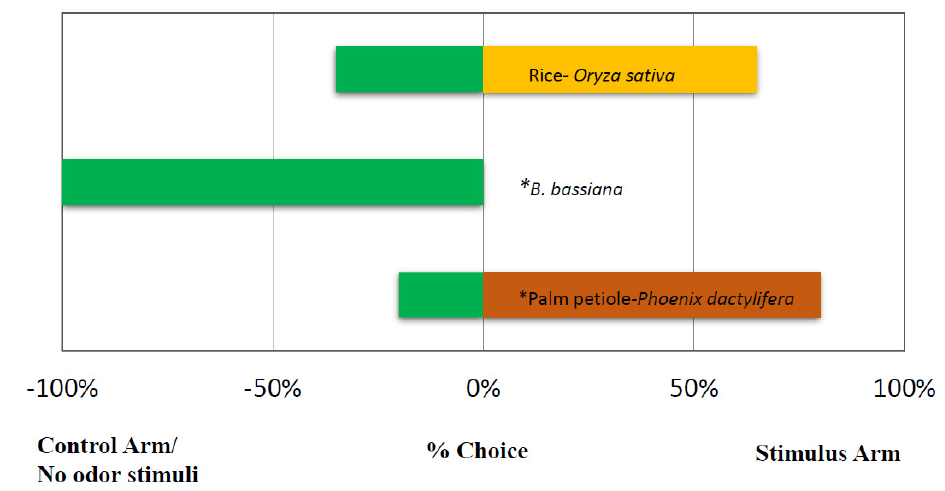
Figure 1. Response of a Rhynchophorus ferrugineus female (%) in a Y-tube olfactometer (10 min) when given a choice between environmental air (control) and odor stimulus (host palms and solid formulation of entomopathogenic fungus B. bassiana . N = 20 individuals per choice test ( p < 0.01, chi-square). * Indicates significant.